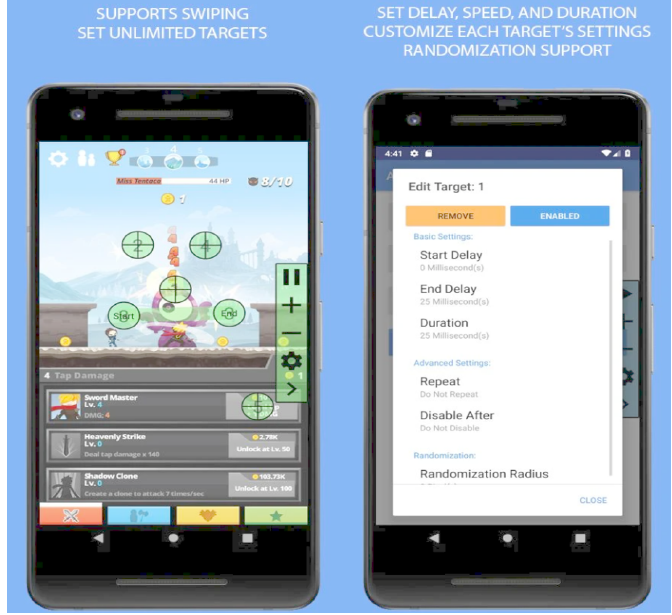
Figure 6. A macro-app without certain conditions (automatic clicker)